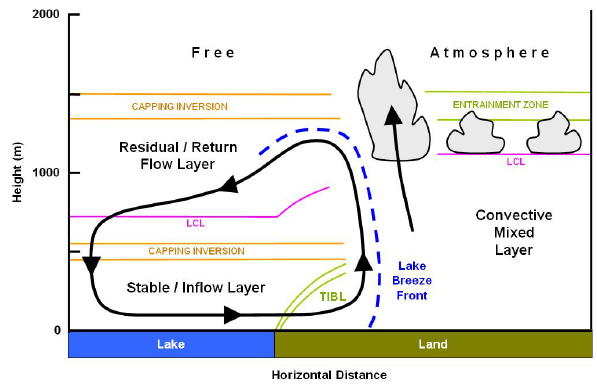
Fig. 2. Vertical cross-section diagram showing an idealized lake- breeze circulation penetrating inland in a calm synoptic wind regime. Arrows show air motions within and adjacent to the lake- breeze circulation. A thermal internal boundary layer (TIBL) is shown growing in vertical extent with distance inland behind the lake-breeze front (blue dashed line). Magenta lines indicate the lifting condensation level (LCL), green outlines indicate entrain- ment zones, and orange outlines indicate capping inversions. Air motions, various layers, and circulation depth are from Ogawa et al. (1986), Stull (1988), and Lyons (1972),